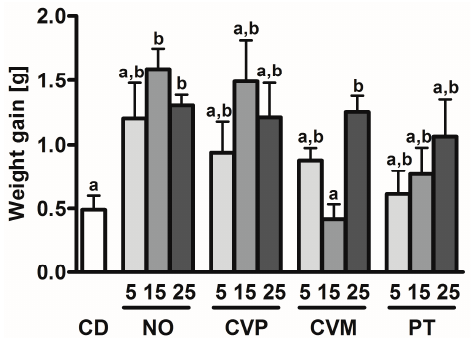
Figure 1. Weight gain of female C57BL/6 mice after 14 days feeding of control diet (CD) or different microalgae diets ( N. oceanica (NO), C. vulgaris phototrophic cultured (CVP), C. vulgaris mixotrophic cultured (CVM), P. tricornutum (PT)) supplemented to 5, 15 or 25% ( w / w ). Data are expressed as means ± SEM ( n = 8). Different letters mark significant differences (ANOVA followed by Tukey’s post hoc test; p < 0.05).